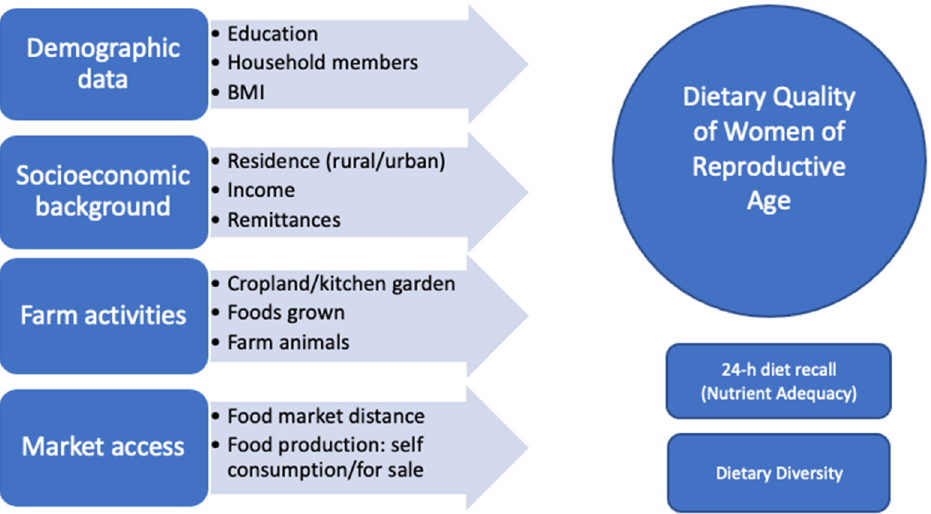
Figure 2. Determining factors impacting dietary quality of WRA (Source: authors’ visualization).